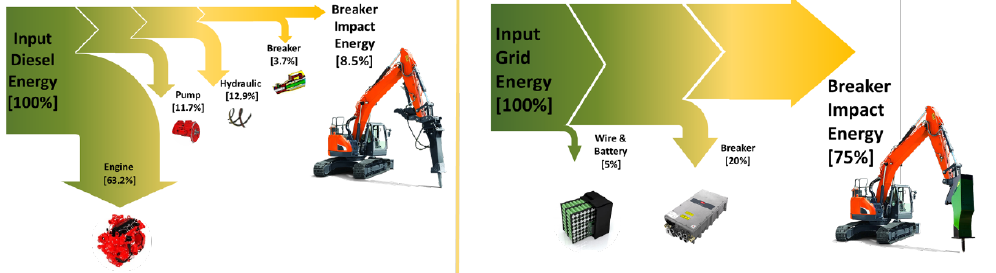
Figure 3. Sankey plot of energy flow through an excavator during operation with a hydraulic hammer adopted from [6] and fully electric